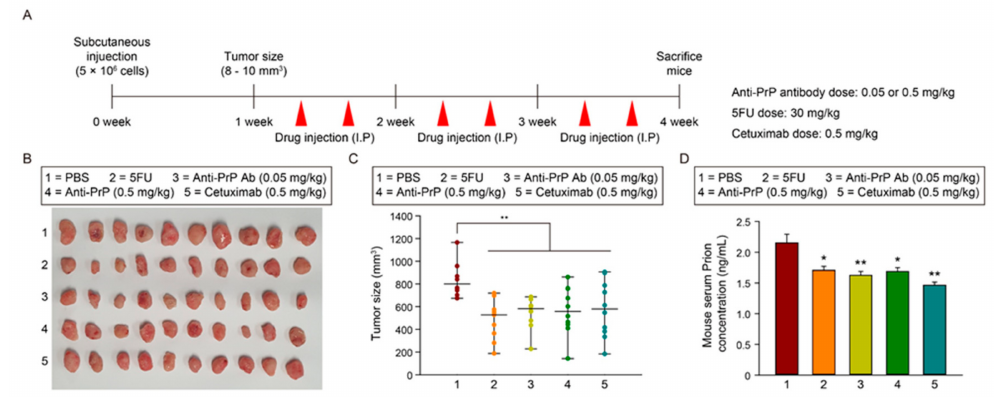
Figure 6. The effect of anti-PrP antibody in a CRC xenograft model. ( A ) Schematic illustration of SNU-C5/WT cells in vivo subcutaneously transplantation and injection with PBS, 5FU, anti-PrP antibodies (0.05 or 0.5 mg/kg), and cetuximab (0.5 mg/kg). ( B ) Photographs of tumor growth in a murine xenograft mouse model. ( C ) Quantification of tumor size in each group ( n = 10). (D) ELISA analysis of PrP C expression in sera isolated from a murine xenograft model ( n = 10). Data are presented as the mean ± SEM. * p < 0.05, ** p < 0.01 (ANOVA).